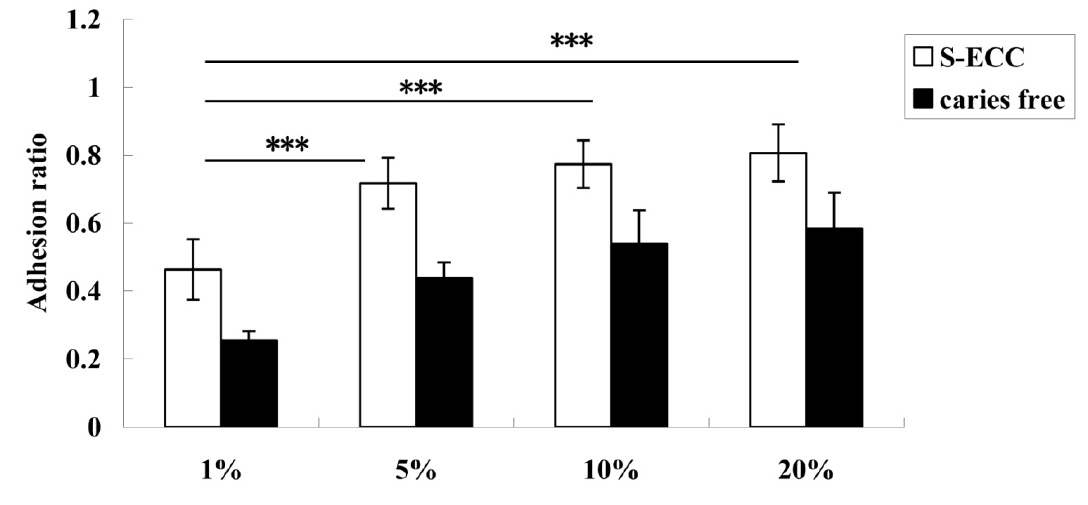
Figure 2. Adhesion ratios of S. mutans from children with ECC and caries-free children when the sucrose concentration was 1%, 5%, 10%, and 20%. The adhesion ratio in the 1% group was significantly lower than that in the 5%, 10%, and 20% groups. There were no significant differences among the 5%, 10%, and 20% groups. *** Denotes statistical significance ( p <